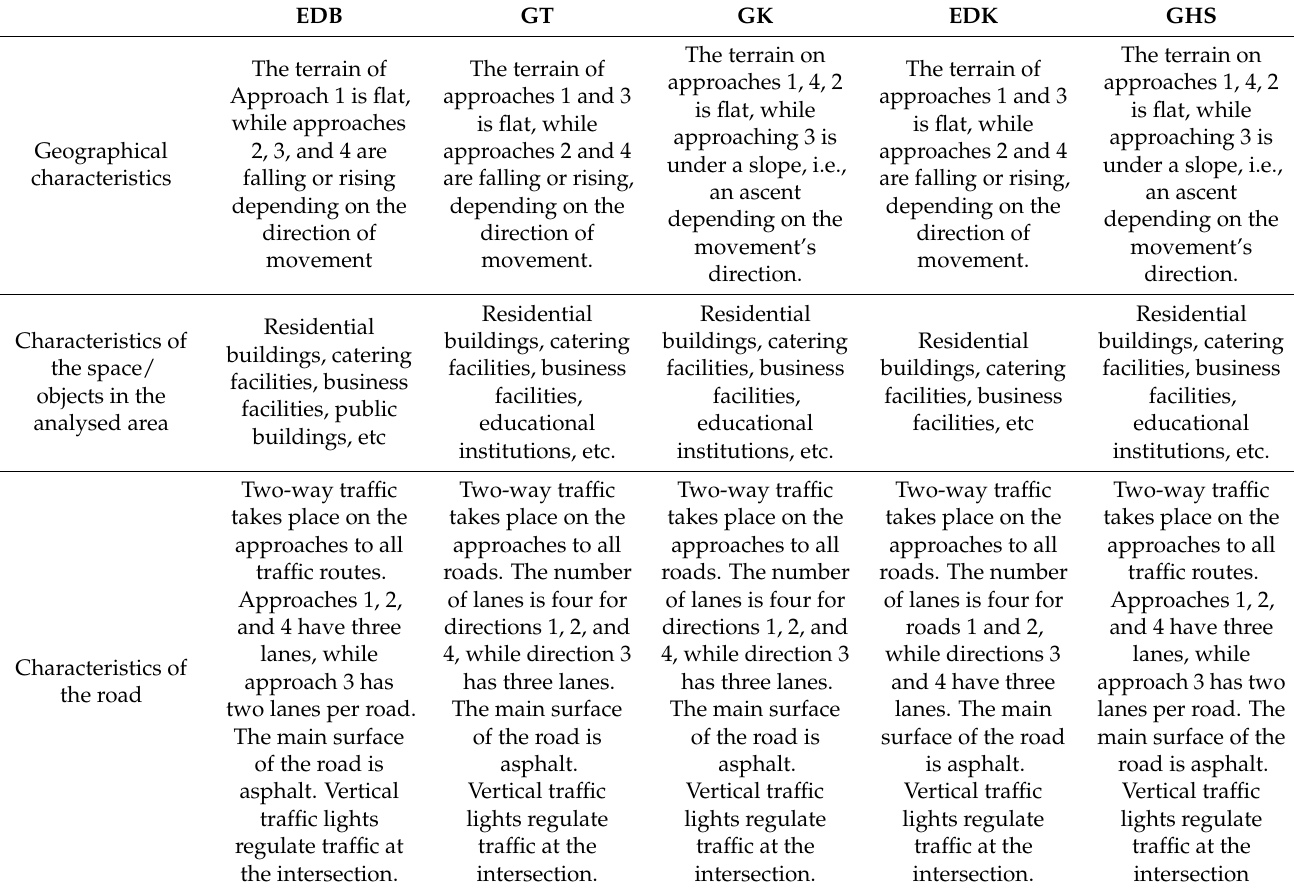
Table 1. Characteristics of analysed